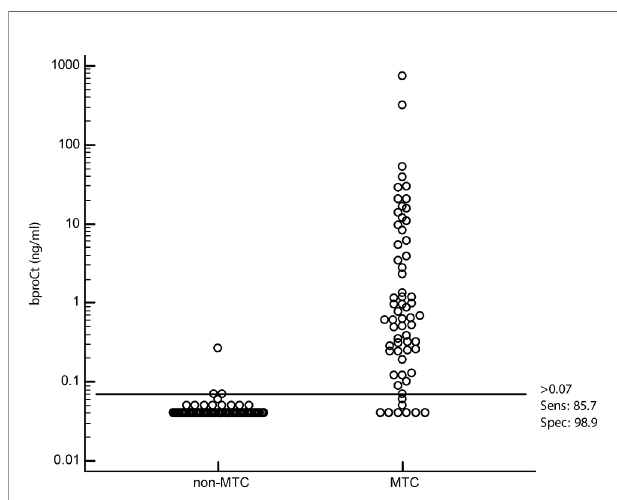
FIGURE 2 | Dot plot diagram showing the accuracy of the proposed cut-off for basal procalcitonin (bproCt) in the diagnosis of MTC in patients with nodular thyroid